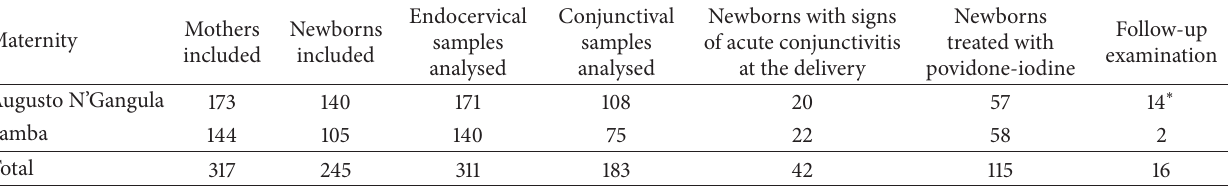
Table 1: Summary of the cases and samples.